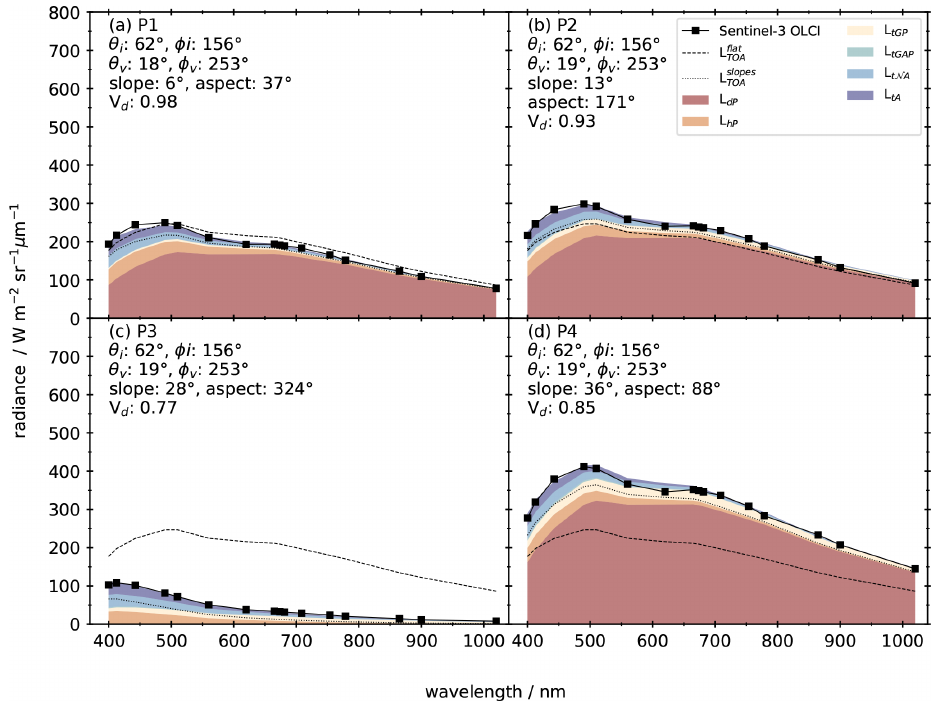
Figure 7. TOA radiance observed by Sentinel-3 OLCI (L1B) and simulated by REDRESS considering the full-rugged-terrain problem (stacked coloured spectra), slopes only (dotted lines), and a flat surface (dashed lines), for 4 pixels with different terrain configurations on 13 February 2018. Note that values for L tGAP are too small to appear on the